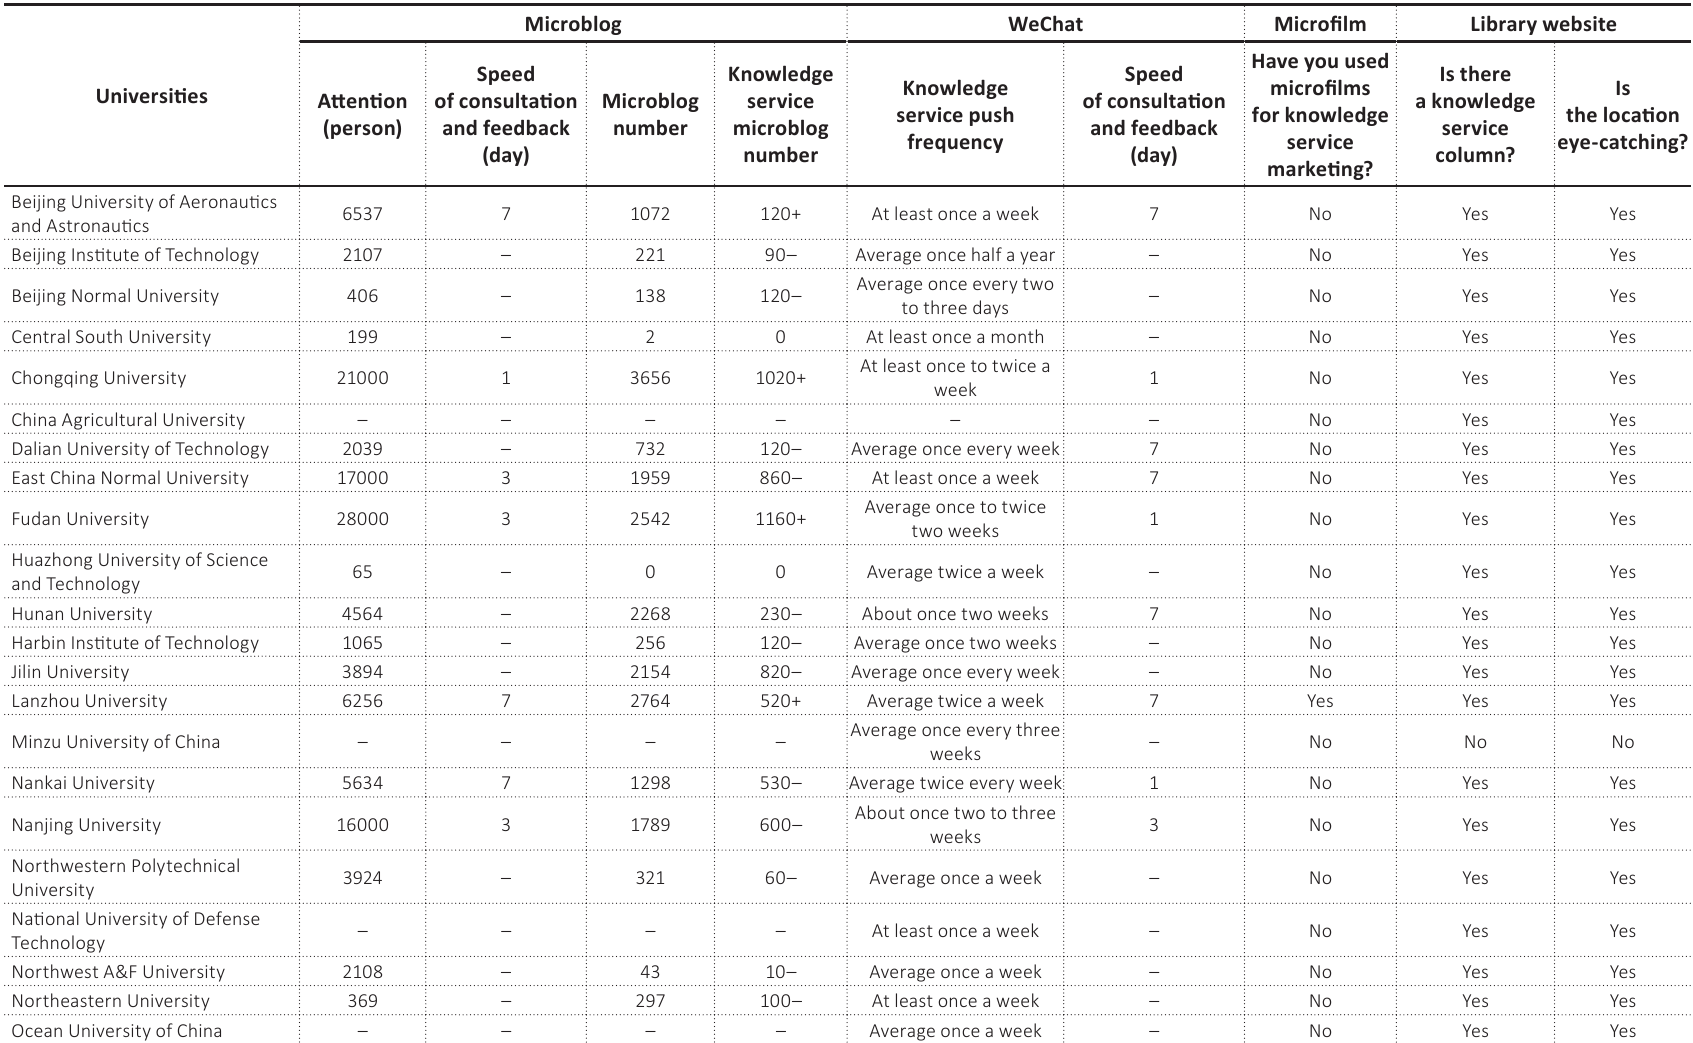
Table 1. Marketing and promotion of knowledge services of “double first-class” university library